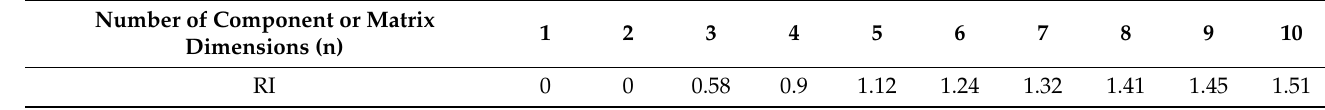
Table 4. Random index for a several matrix dimensions [160].